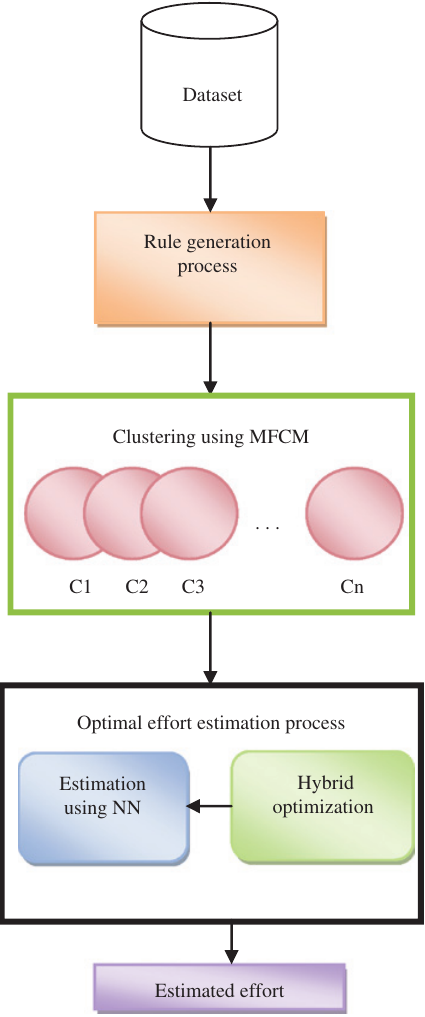
Figure 1: Proposed Software Effort Estimation